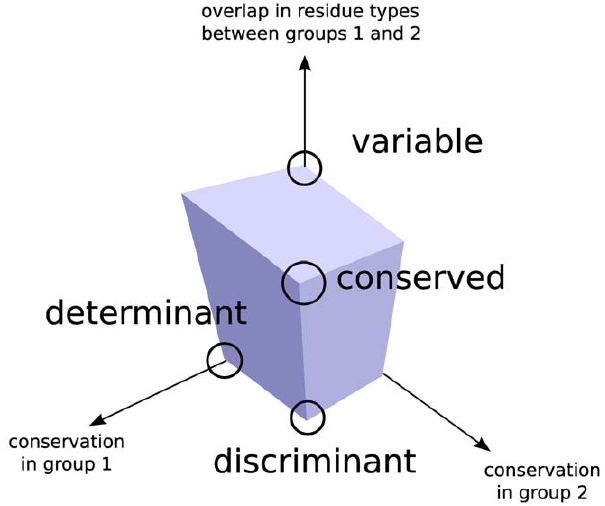
Figure 1. The main components of the information available from comparative analysis of two groups of paralogous sequences. The nomenclature we use in this paper for the three main types of behavior is also